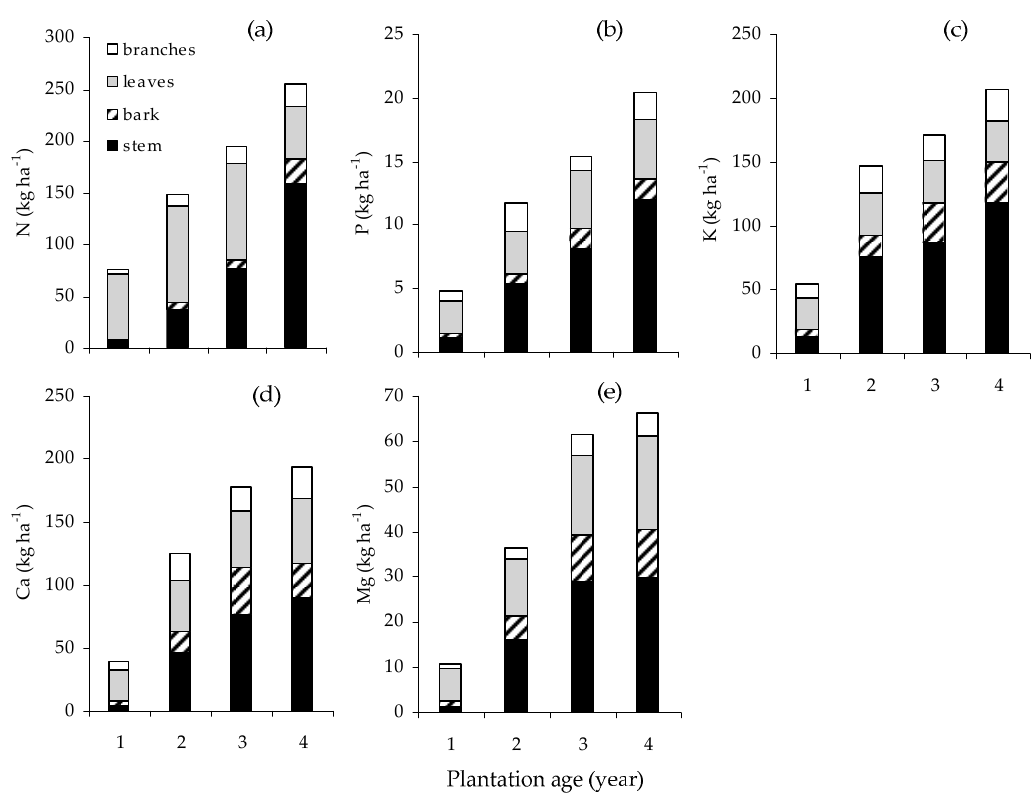
Figure 3. Accumulation of N ( a ), P ( b ), K ( c ), Ca ( d ) and Mg ( e ) contents (kg ha − 1 ) of E. pellita with plantation plantation age.